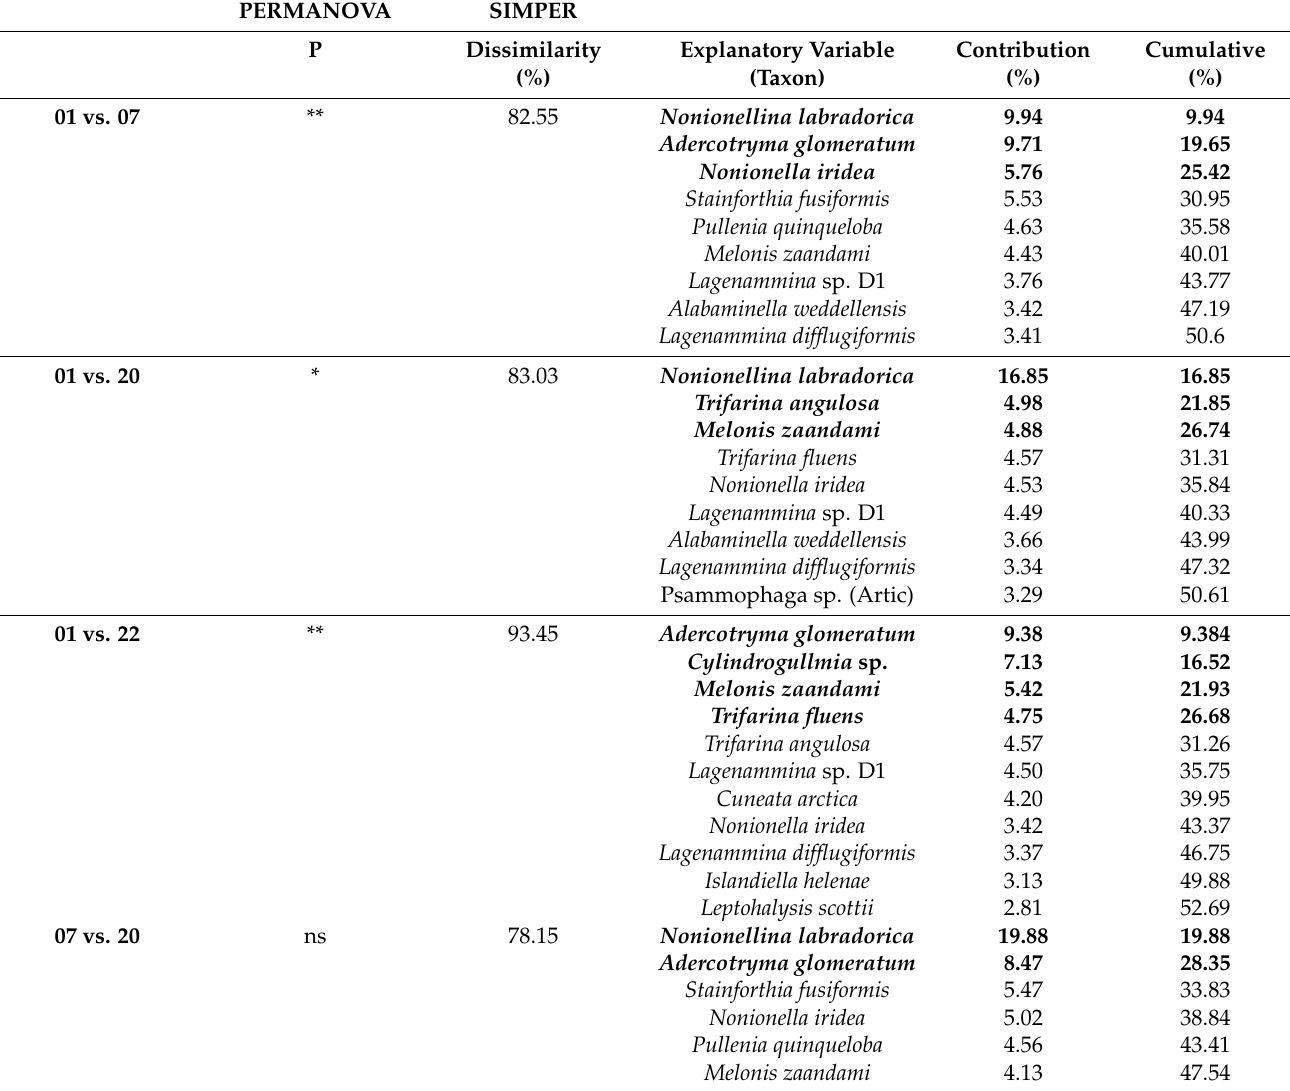
Table 3. Dissimilarity in foraminiferal species composition among sampling periods and variables responsible for the estimated differences. Reported are the results of the SIMPER and PERMANOVA analyses (ns = not significant; * p < 0.05; ** p < 0.01; *** p < 0.001). In bold, species contributing to >25% of